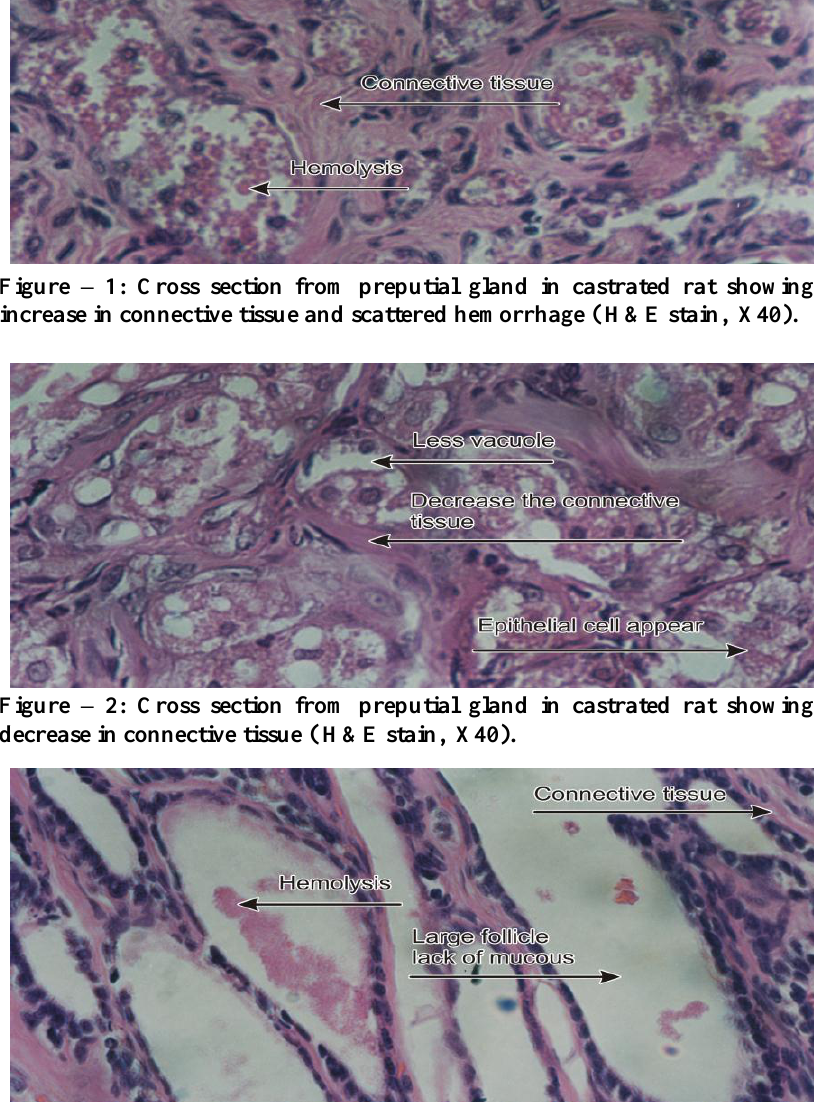
Figure – 3: Cross section from seminal vesicle of castrated rat showing atrophy of epithelial cell and lack of mucus in the lumen ( H&E stain, X40).